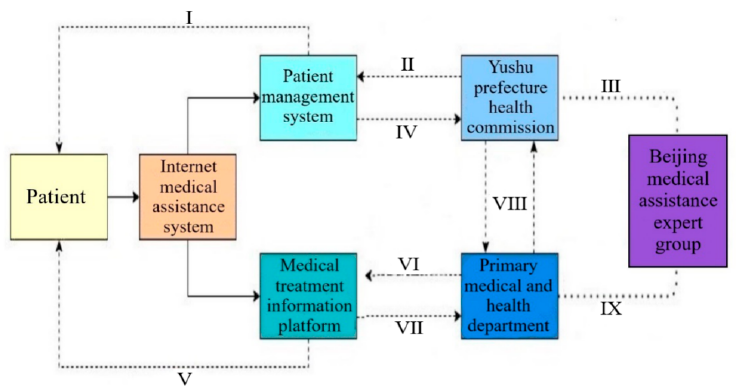
Figure 11. The Flowchart of Beijing-Qinghai Internet Online Medical Assistance. Note: I Implement precise management; II Logging data; III Consultation and treatment; IV Visualized patient condi- tion analysis; V Implement efficient diagnosis and treatment; VI Master patient’s situation; VII Organize, guide and advance; VIII Data sharing; IX Consultation and